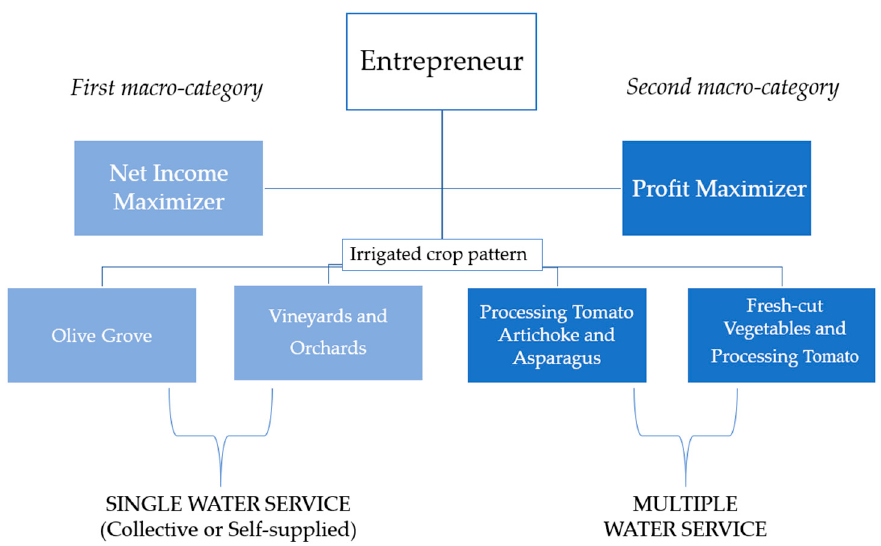
Figure 2. Cluster results representation. Source: our elaboration.